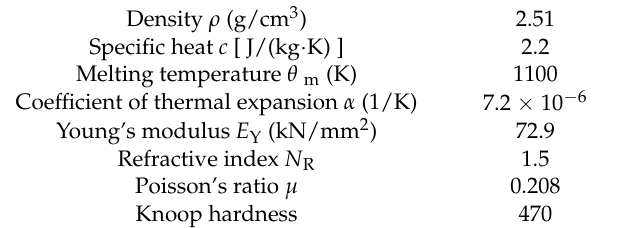
Table 1. Specifications of borosilicate glass D263.